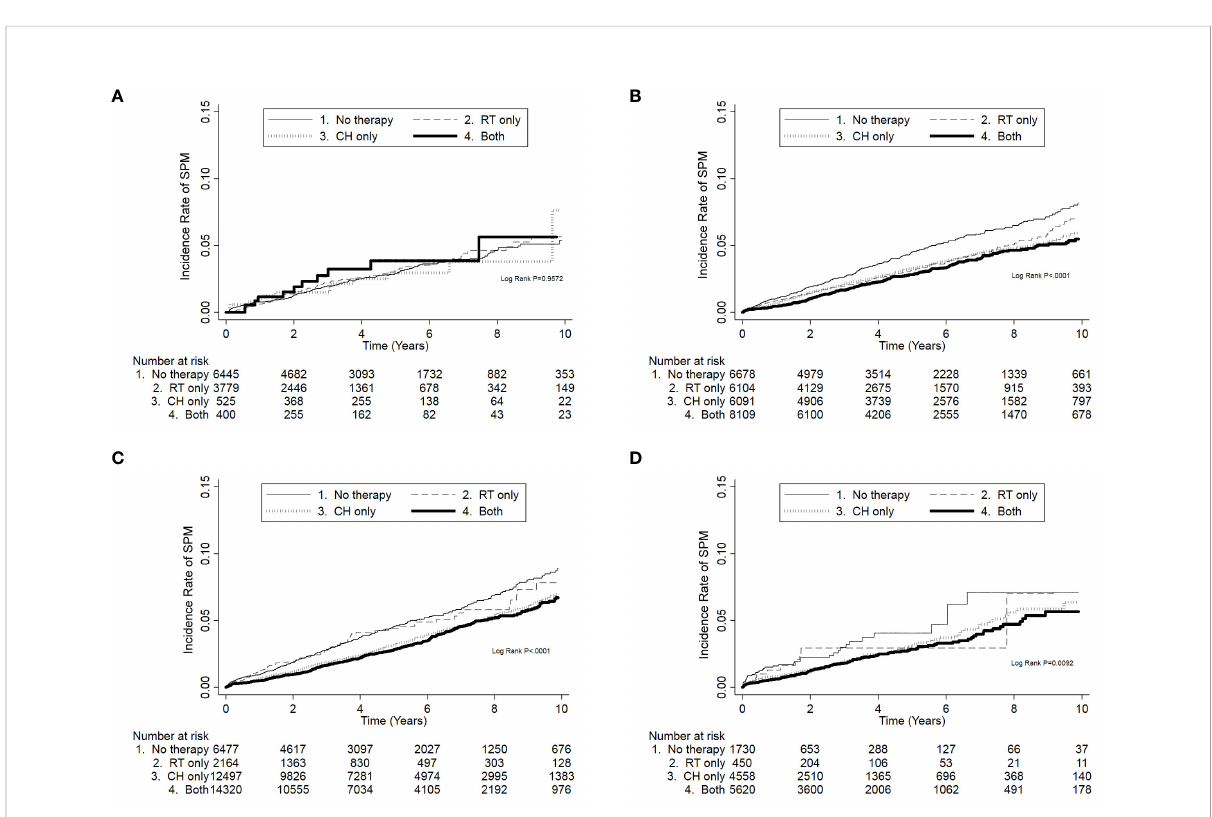
FIGURE 2 The cumulative incidence of developing second primary malignancies (SPMs) according to chemotherapy and radiotherapy in different American Joint Committee on Cancer breast cancer stages. (A) SPM risk was not associated with chemotherapy and radiotherapy in stage 0. (B – D) SPM was related to chemotherapy and radiotherapy in stages I, II, and III/IV. When both therapies were used, SPM risk was the lowest. CH, chemotherapy; RT,